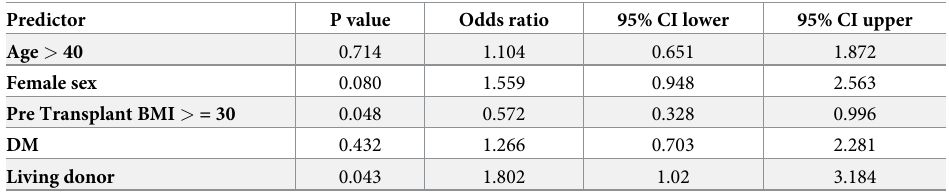
Table 4. Multivariate analysis for risk